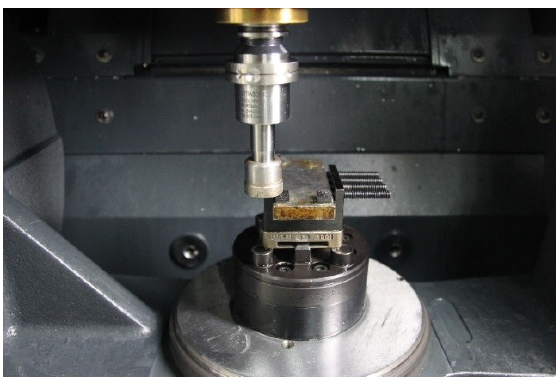
Figure 2. Test devices for ultrasound-assisted cutting with a single abrasive particle.